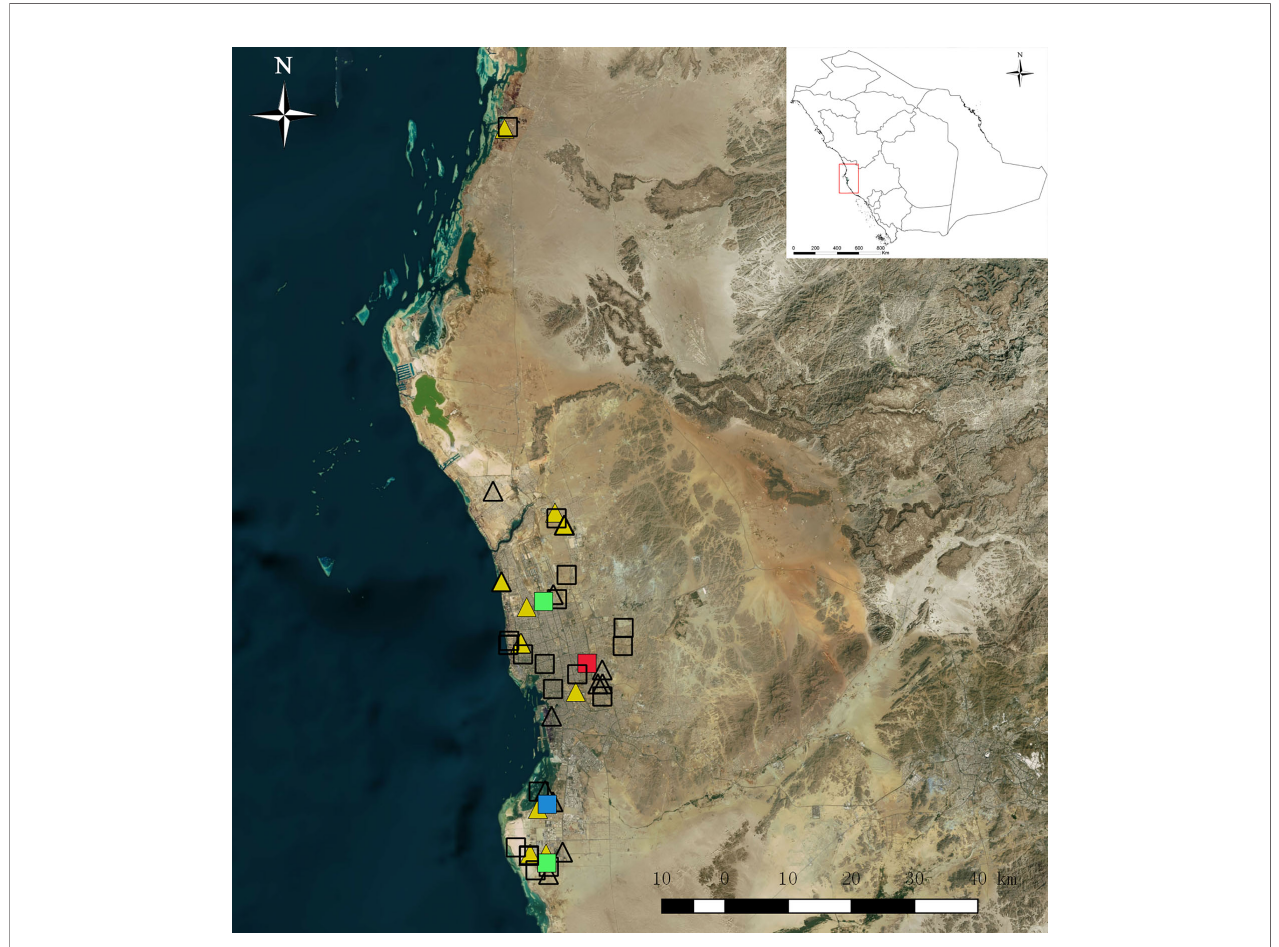
FIGURE 1 | Map of mosquito collection sites in 2016 in Jeddah, Saudi Arabia. Squares represent collection sites of Aedes aegypti , triangles represent sites of Culex quinquefasciatus . Color symbols fi lled with red, yellow, green, and blue represent dengue virus, Culex fl avivirus, Phlebotomus-associated fl avivirus (PAFV), and co- cell fusing agent virus & PAFV detection,